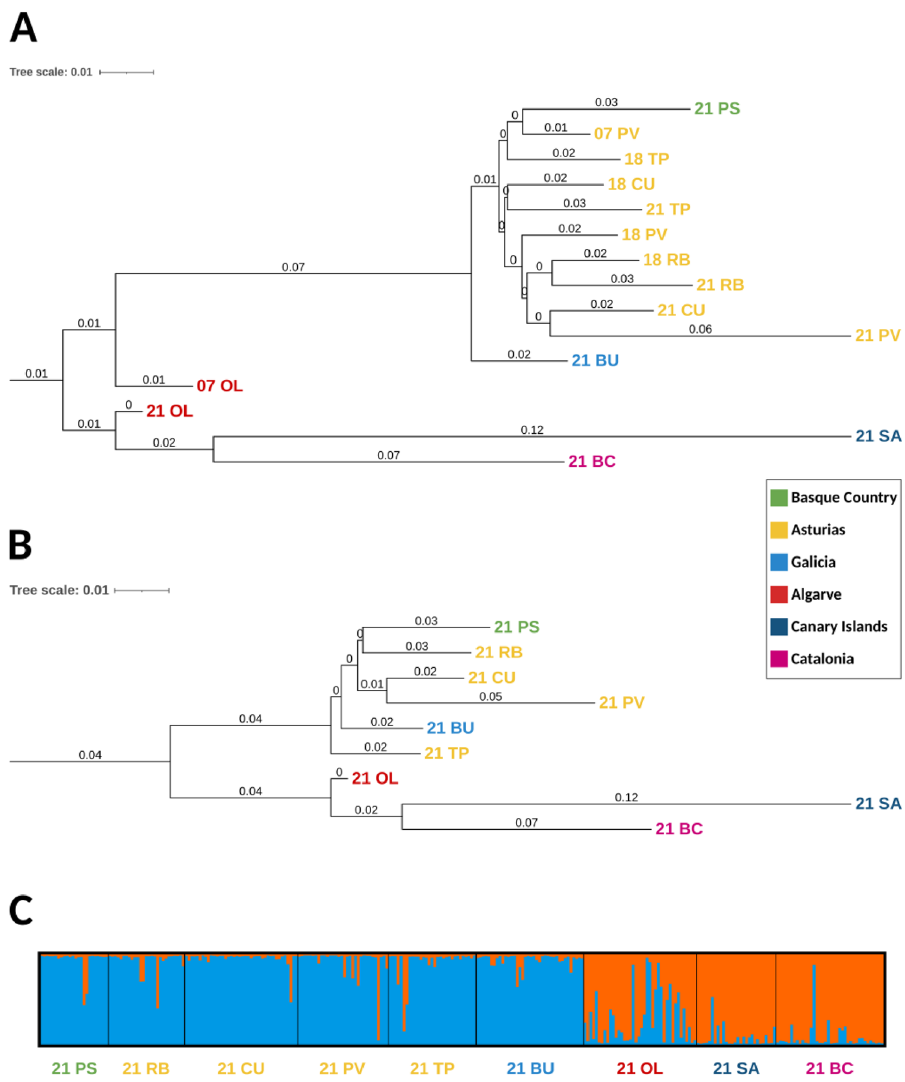
Figure 4. Neighbor-joining trees using D A distance 57 and bayesian analysis of O. vulgaris populations in this study. ( A ) Global analysis for the 9 localities showing all the fishery seasons, ( B ) global analysis for all localities showing only the 2020–2021 fishery season, ( C ) Structure bar-plot showing the assignment probabilities for each genotyped individual from 2020–2021 fishery season under admixture model. Each bar corresponds to one individual. Labels indicate the fishery season (first two digits) and the locality (Pasaia (PS), Ribadesella (RB), Cudillero (CU), Puerto de Vega (PV), Tapia de Casariego (TP), Bueu (BU), Olhão (OL), San Andrés (SA), Barcelona